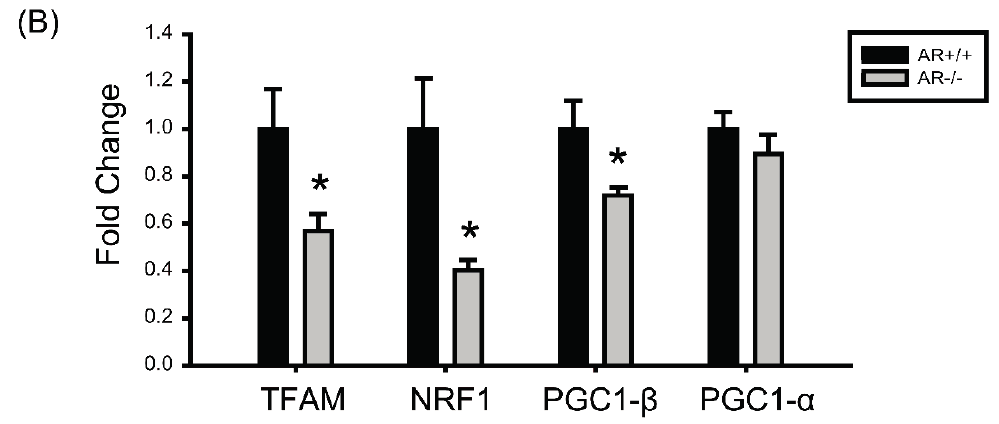
Figure 6. Decreased mitochondrial biogenesis in granulosa cells of AR − / − mice. ( A ) Decreased mitochondrial DNA (mtDNA) copy number in granulosa cells of AR − / − mice. mtDNA copy number was calculated using reverse transcription-PCR and quantitative real-time PCR by measuring the ratio of COX 2 (mtDNA) to Rn18s (nuclear DNA) DNA levels in granulosa cells of AR +/+ and AR − / − mice. * p < 0.05, n = 4 mice per genotype; the lane marked B indicates blank control; ( B ) Decreased mitochondrial biogenesis in granulosa cells of AR − / − mice. The mRNA levels of genes implicated in mitochondrial biogenesis determined by real-time RT-PCR in granulosa cells of AR +/+ and AR − / − mice. At least three experiments were performed and data are presented as the mean ± SEM. * p < 0.05, n = 4 mice per genotype. PGC-1: peroxisome proliferator-activated receptor γ coactivator-1. NRF1: nuclear respiratory factor 1. TFAM: mitochondrial transcription factor